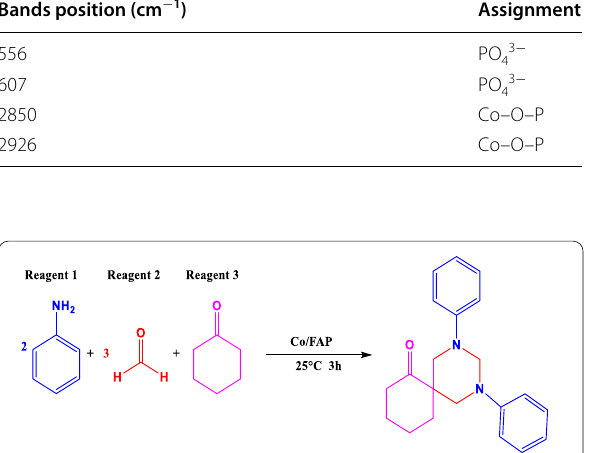
Table 1 Infrared bands of Co/Fap Bands position (cm − 1 ) Assignment